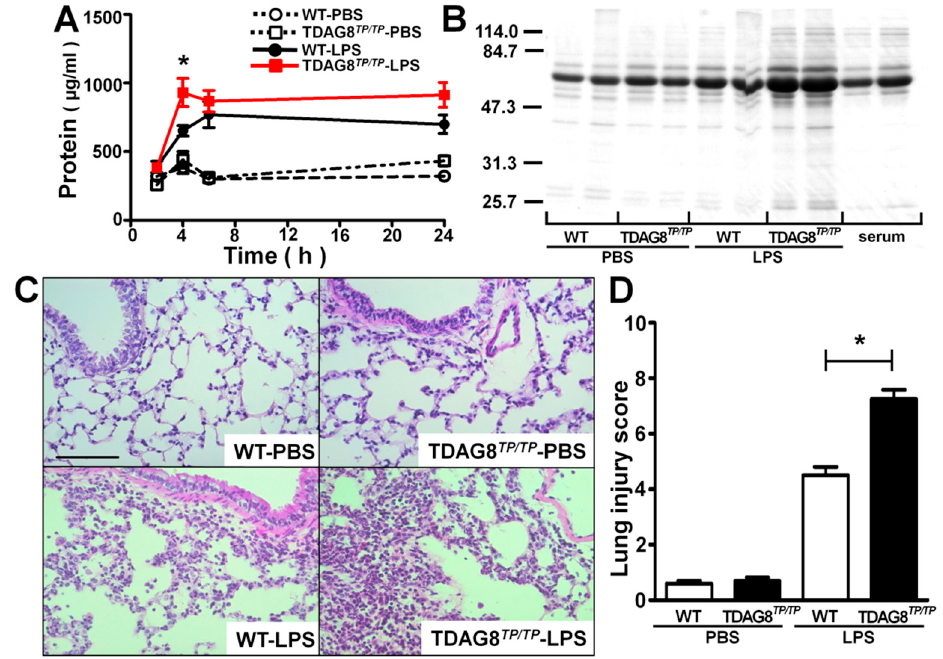
Figure 4. The LPS-induced protein penetration and lung injury are greater in TDAG8 -deficeient mice than in WT mice. ( A ) BAL fluid samples were collected at the indicated time after PBS or LPS instillation for measurement of protein concentration. Data are mean ± SEM of n = 12–17 for each group. The effect of TDAG8 deficiency is significant, * p < 0.05 ( TDAG8 TP/TP -LPS vs. WT-LPS); ( B ) Proteins of BAL fluid sample (duplicate for each group) were separated by SDS-PAGE and stained with Coomassie brilliant blue. Mouse serum at two different concentrations (right two lanes) was used as standard; ( C ) Histological analysis of lung sections was performed 4 h after PBS or LPS instillation. Three representative lung sections per mouse, from 5–10 mice, are shown for each group. Scale bar is 100 µm; ( D ) Lung injury scores by analysis of histopathological sections from lungs 4 h after PBS or LPS instillation. Data are mean ± SEM of n = 5–10 for each group. The effect of TDAG8 deficiency is significant, * p < 0.05 ( TDAG8 TP / TP -LPS vs. WT-LPS).